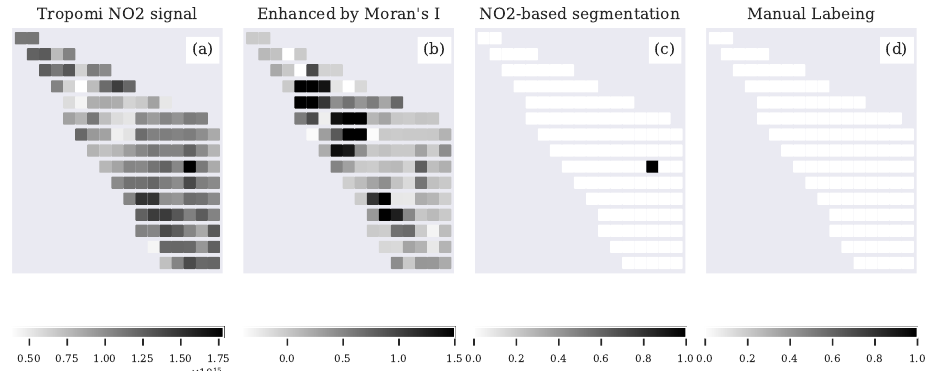
Figure 16. NO 2 -based thresholding allows for distinguishing plumes cumulated within one pixel of the TROPOMI image. ( a ) TROPOMI NO 2 tropospheric vertical column density. Units: mol/m 2 . ( b ) TROPOMI NO 2 image enhanced by Moran’s I . At the top left of the ship sector can be found an example when a cluster of low-value NO 2 was enhanced incorrectly. ( c ) Results of the segmentation of the NO 2 threshold method. A black pixel is a pixel that was identified by a model as a plume. ( d ) Human labels. The absence of black pixels means that there were no pixels within the area labeled as a plume. For all presented images, the size of the pixel is equal to 4.2 × 5 km 2 . Measurement date: 9 June 2019. Ship type: tanker. Ship length: 285 m. Average speed within the studied time scope: 15.4